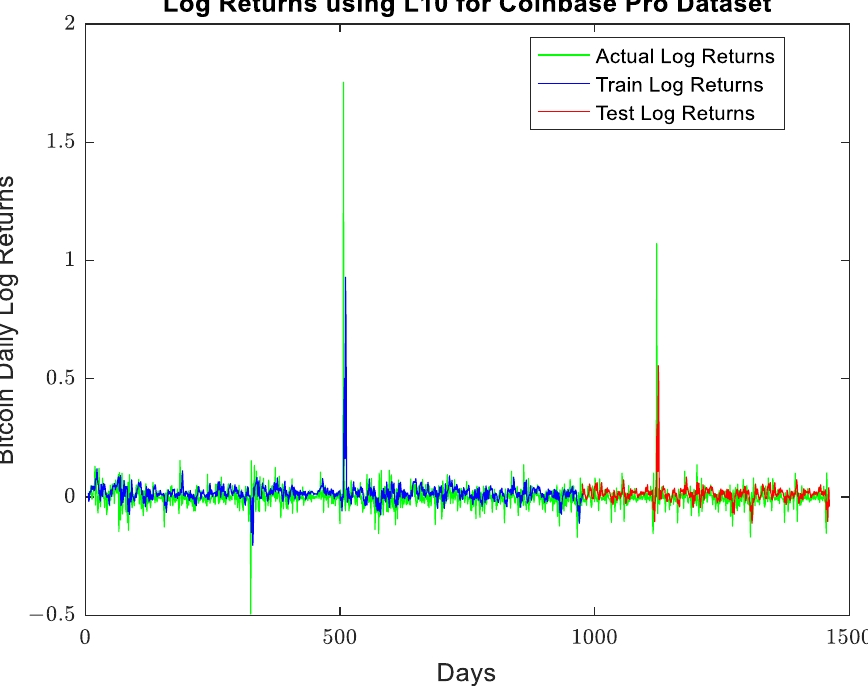
Figure 16. Training, testing and actual Bitcoin log returns of Legendre based neural network model using proposed dual normalized Coinbase Pro dataset .